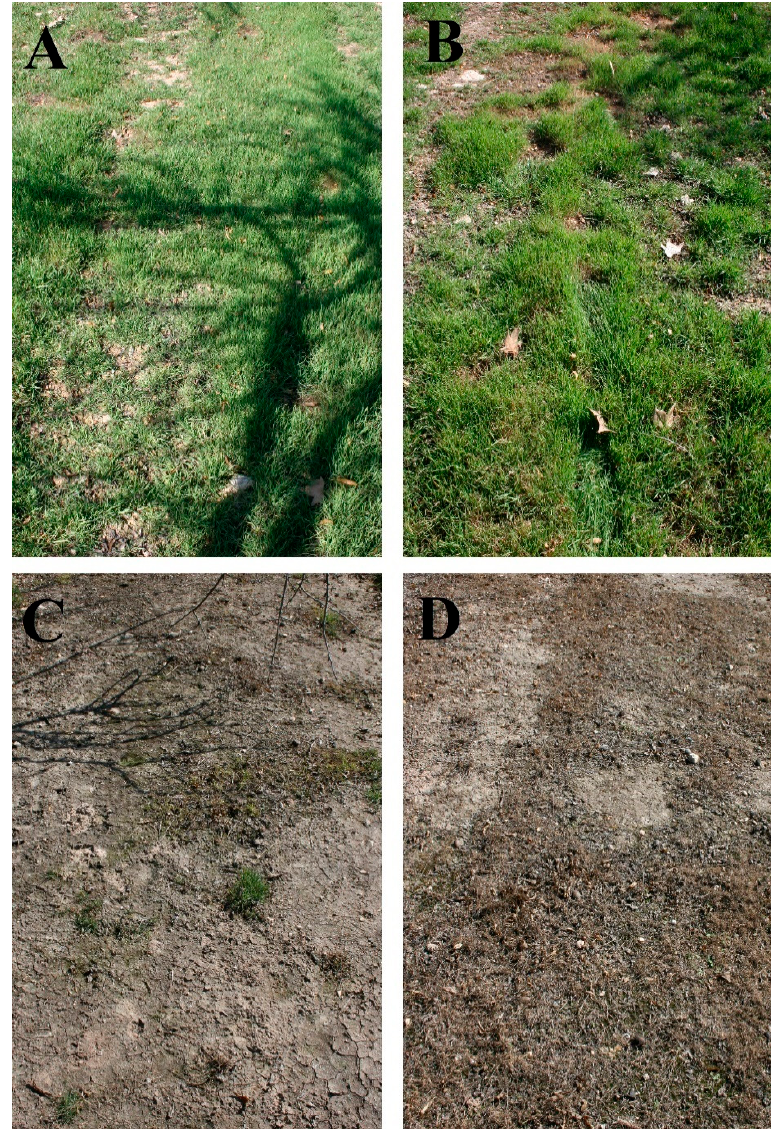
Figure 5. Percentage of Bromus rubens control. ( A ) Untreated, ( B ) glyphosate (1080 g ae ha − 1 ), ( C ) flazasulfuron + glyphosate (50 + 1080 g ai/ae ha − 1 ) and ( D ) glyphosate + propaquizafop (1080 + 100 g ae/ai ha − 1 ) at 90 days after application (DAA).